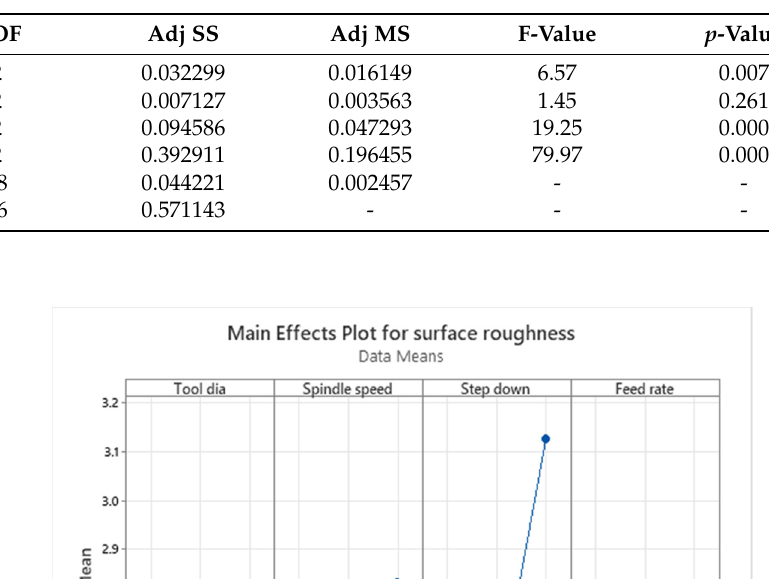
Table 8. ANOVA of GFRG.